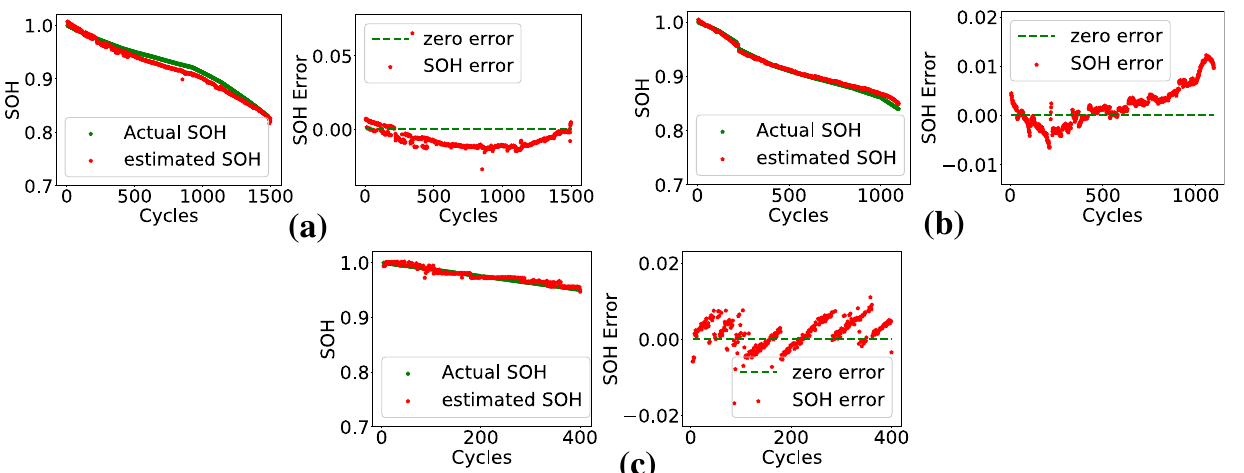
Figure 4. Plots of actual and estimated SOH, and error for laboratory testing. ( a ) S1-B3: 0.8C, CCCV charging, ( b ) S1-B6: 1.2C, CCCV charging, and ( c ) S6-B1: 1C MSCCCV charging.